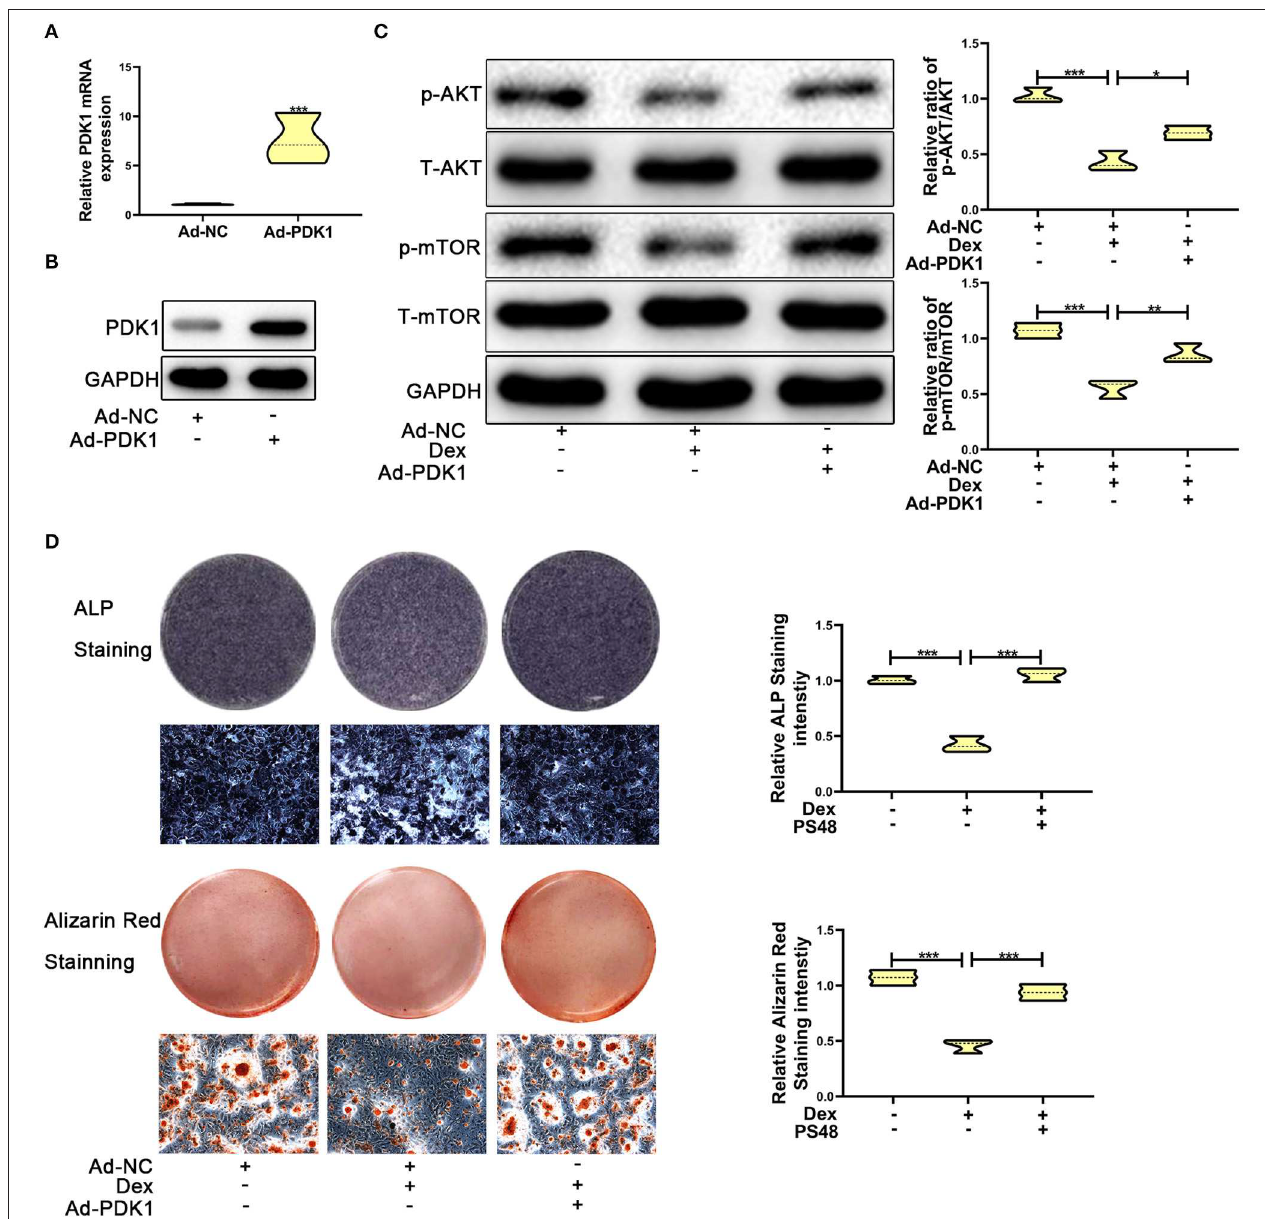
FIGURE 5 | Upregulation of PDK1 by Adenovirus-PDK1 promoted the osteogenic ability of MC3T3-E1 cells by activating the AKT/mTOR pathway. (A) The expression of Adenovirus-PDK1 was confirmed by qRT-PCR. (B) The effect of Adenovirus-PDK1 was confirmed by qRT-PCR. (C) Western blotting was performed to detect the protein expression levels of p-AKT, total-AKT, p-mTOR, total-mTOR, and GAPDH in MC3T3-E1 cells exposed to empty vector, dexamethasone, and dexamethasone + Adenovirus-PDK1, respectively. (D) ALP and Alizarin red staining were performed to determine the osteogenic ability of MC3T3-E1 cells treated with empty vector, dexamethasone, and dexamethasone + Adenovirus-PDK1, respectively. Scale Bar = 20 µ m. Differences were considered as statistically significant when p < 0.05. *** p < 0.001, ** p < 0.01, * p < 0.05.